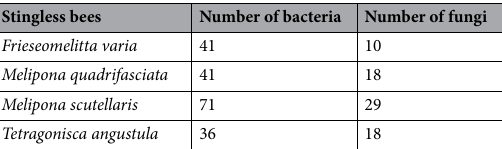
Table 4. Number of microorganisms isolated and preserved in the